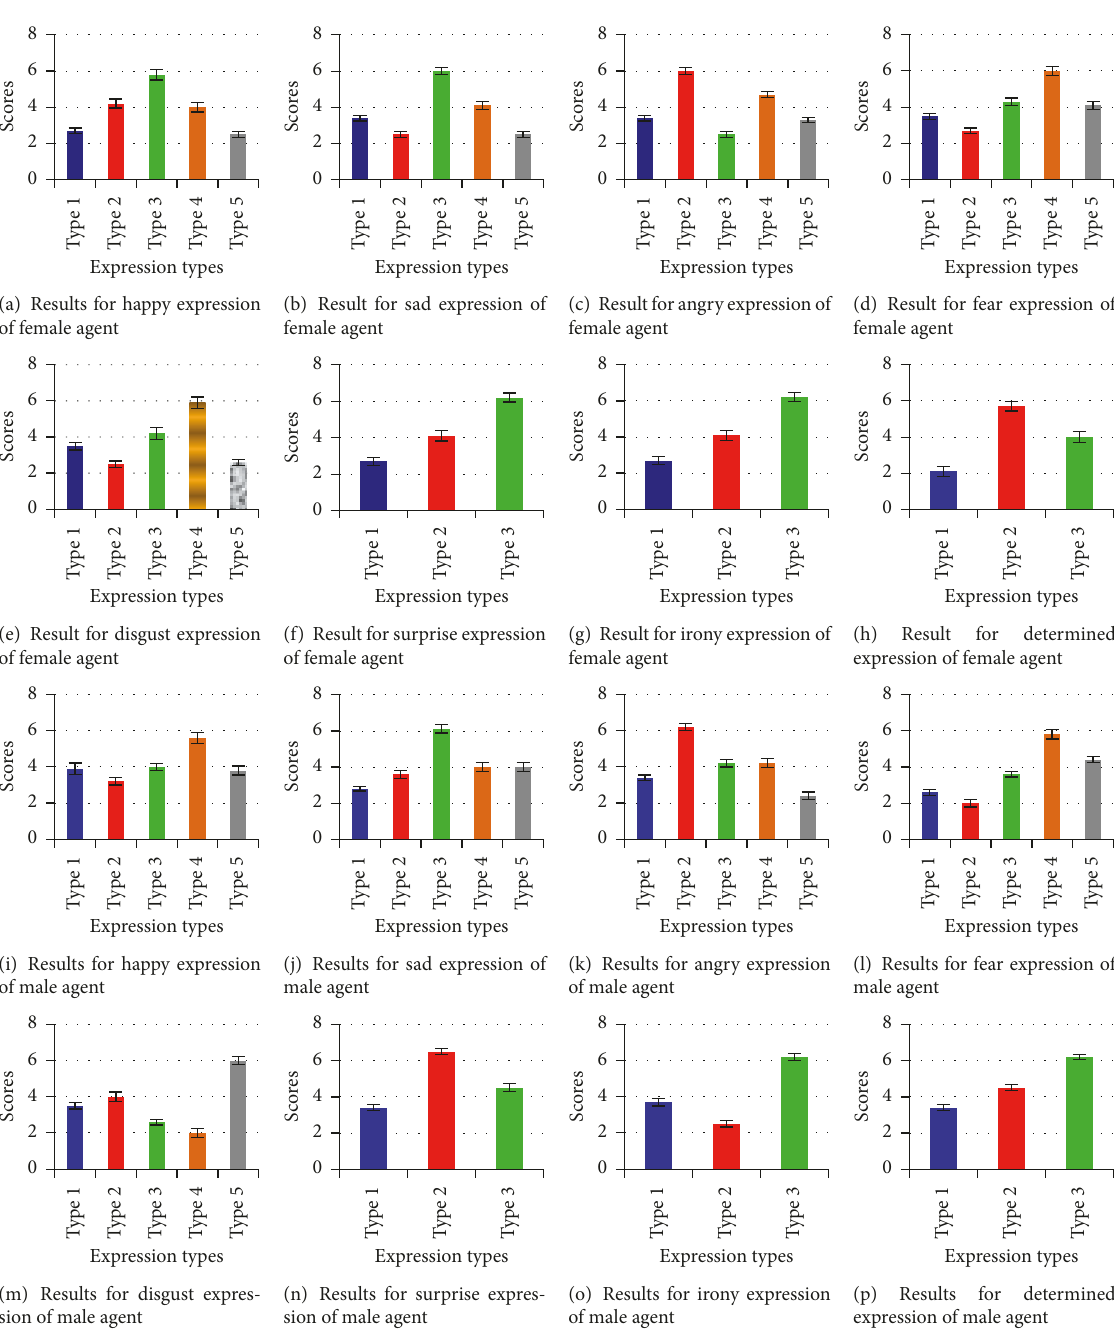
Figure 6: Evaluation results for both female and male